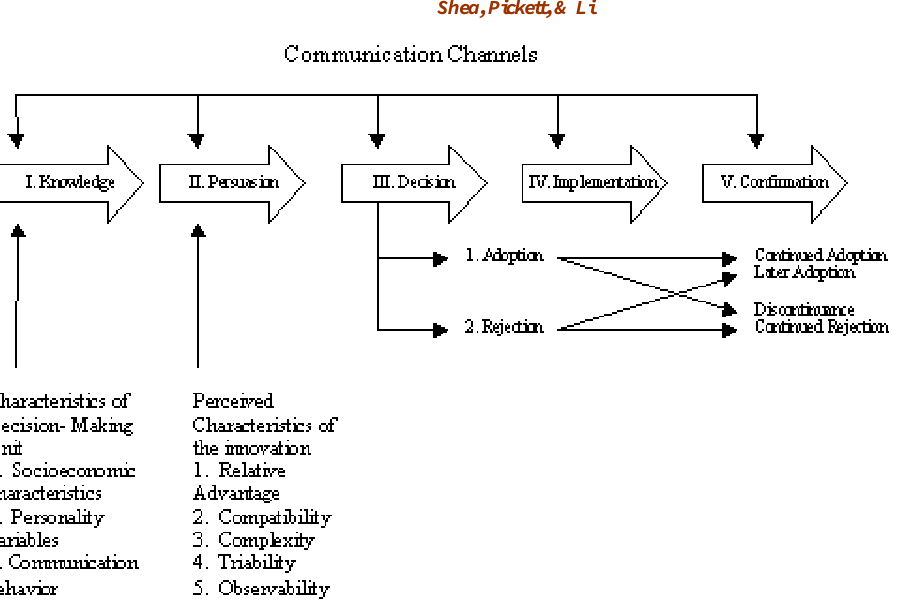
Figure 1. Rogers’ (2003) Diffusion of Innovation